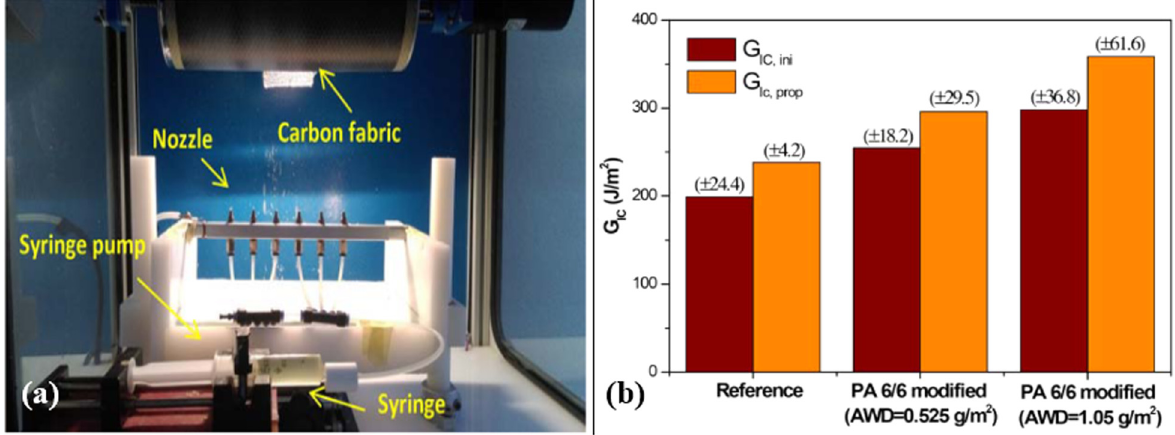
Figure 10: ( a ) Direct deposition of nano fi bers on prepreg and ( b ) improvement in interlaminar fracture toughness [ 120 ] ; Reproduced with permission from John Wiley and